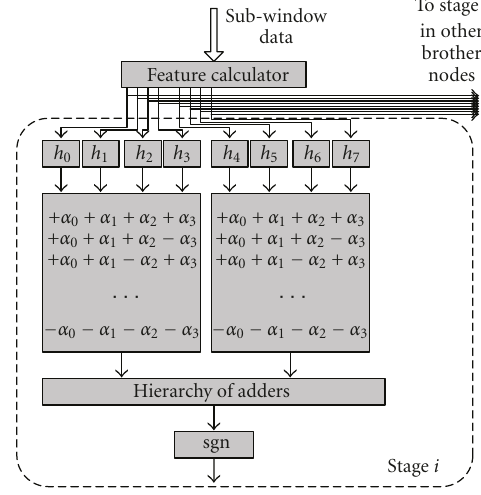
Figure 8: Improved structure of the strong classifier.